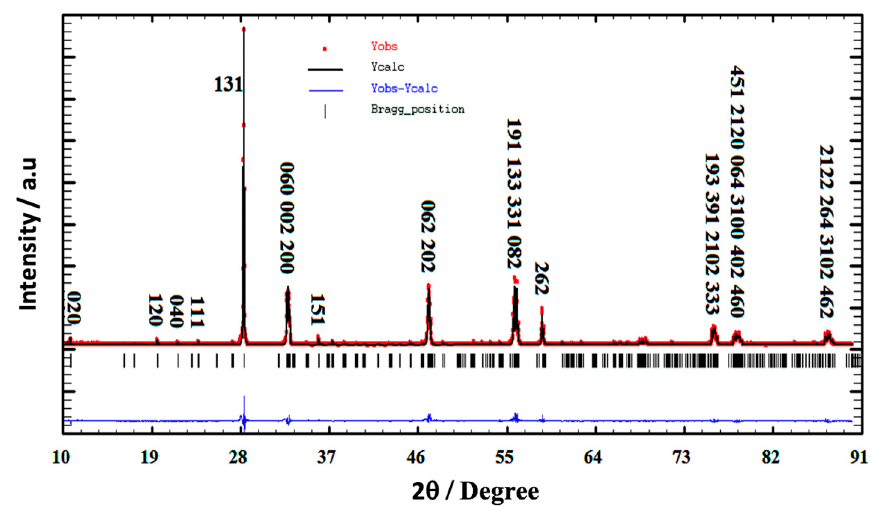
Figure 2. Rietveld refinement profiles and the corresponding Bragg positions. Table 1. Final Rietveld parameters and atomic positions for the BWO at 900 °C. Lattice Parameters: a , b , c